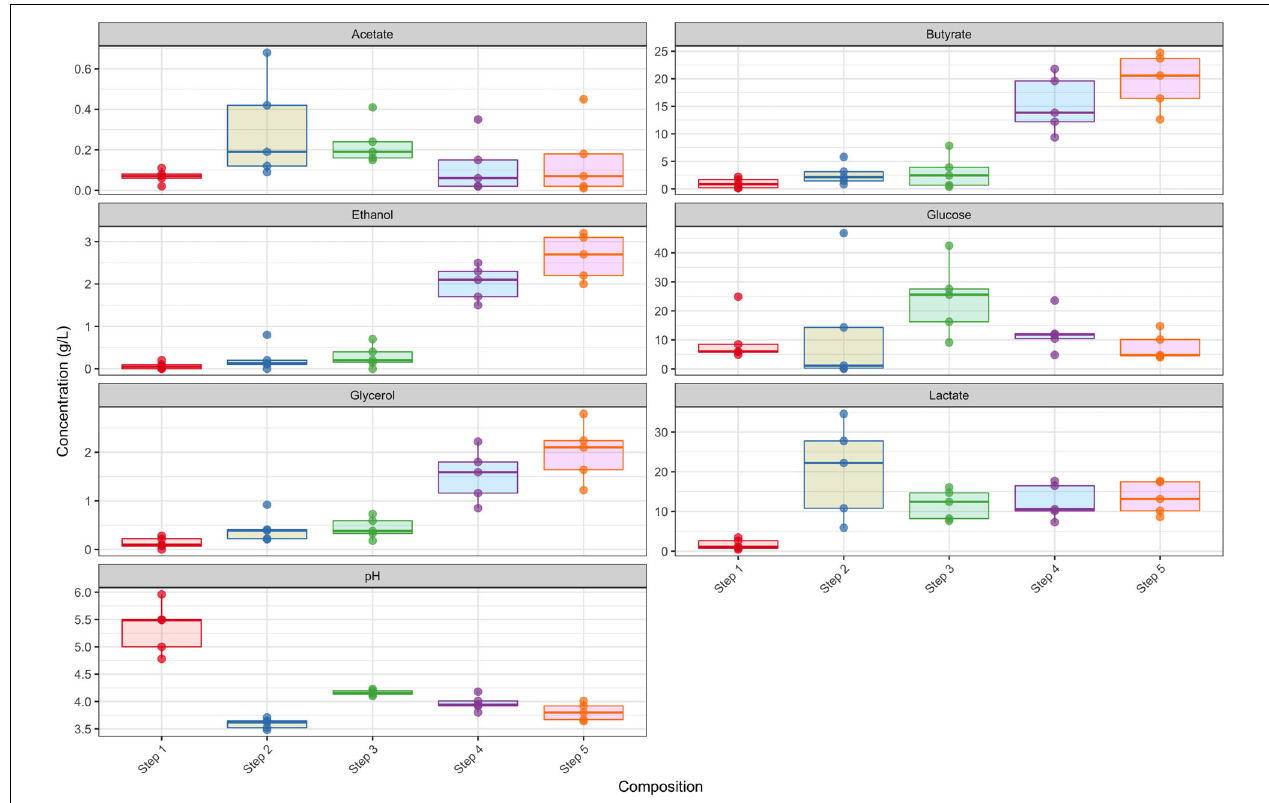
FIGURE 6 | Chemical profiles during the respective steps of the breweries. Each step is representative of the profile of that step in the five different breweries.